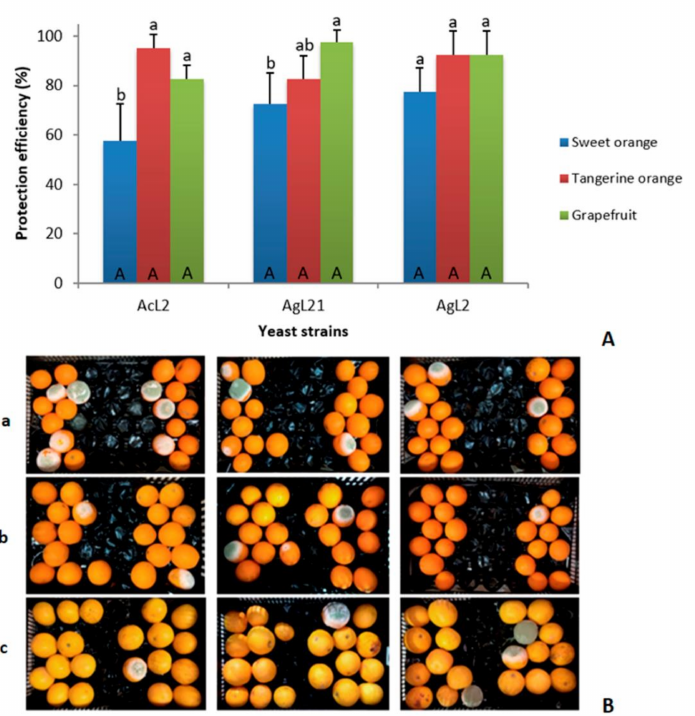
Figure 5. Protection efficiencies of potential yeast candidates against P. digitatum in citrus fruits. The upper panel ( A ) shows the protection efficiency of the three isolates against the pathogen in citrus cultivars. Mean values marked with identical letters are, according to the Tukey test ( p < 0.05),